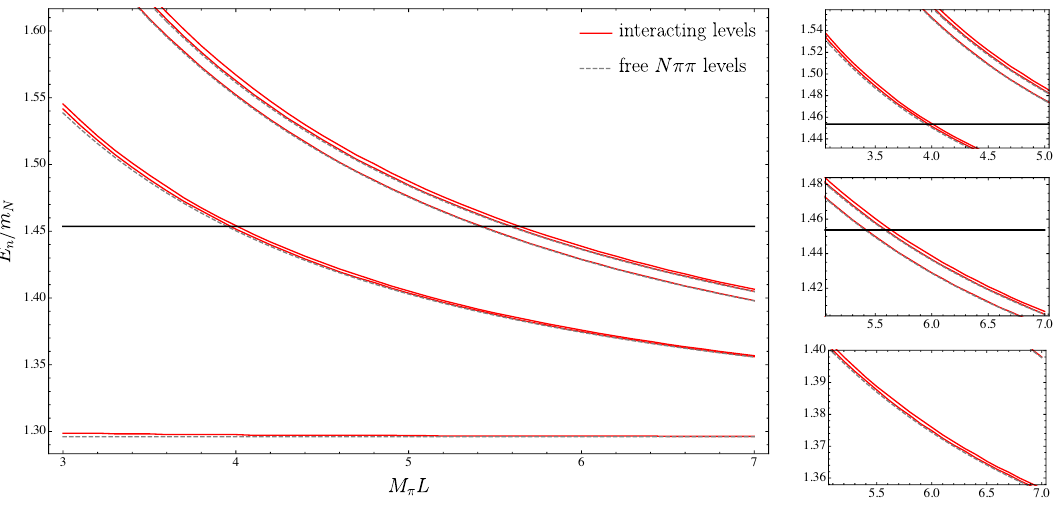
Figure 5 . Energy levels for different box sizes L considering only pion and ∆ -dimer as intermediate states. Red solid lines display the numerical results for the interacting energy levels and grey dashed lines the free (non-interacting) lowest-lying three-particle Nππ energy levels. The thick solid black line marks the mass of the Roper resonance. The small pictures on the right-hand side show more precisely the behaviour of the close lying energy